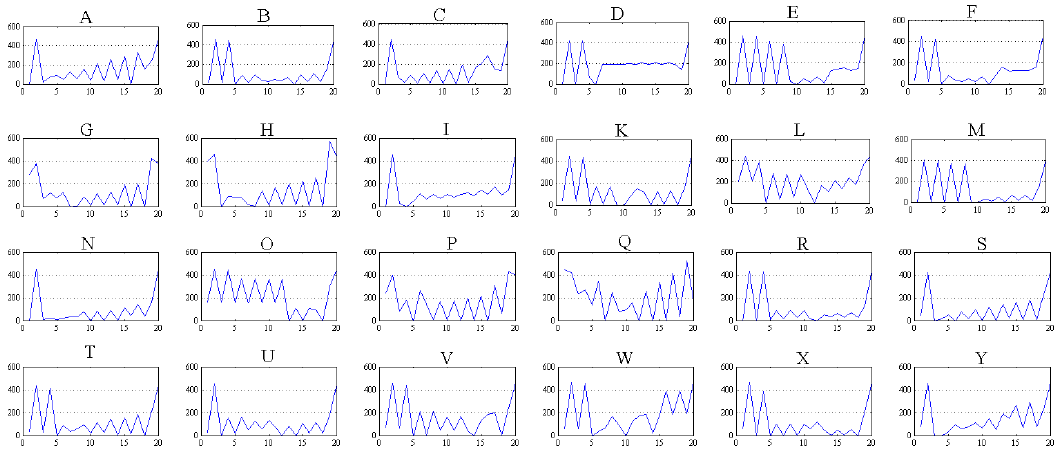
Figure 22. ASL alphabet signs signature used including letters from A to Y excluding letter J, where the X -axis represents the 20 X – Y coordinates of the 10 characteristic pixels in the format (X1, Y1, X2, Y2, . . . , X10, Y10) and the Y -axis represent the value of the coordinates.